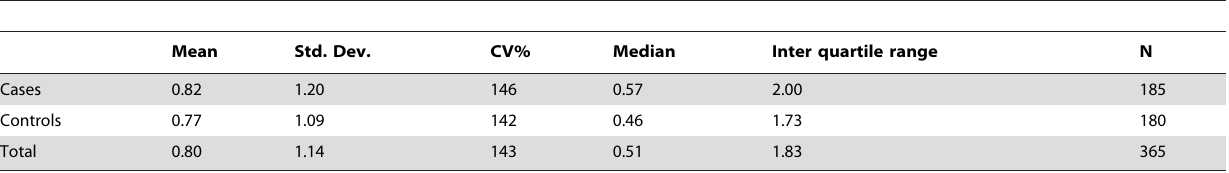
Table 2. Summary statistics (mean, standard deviation, median, interquartile range, number of subjects) for ‘‘ln_adducts’’ in cases, controls, and total